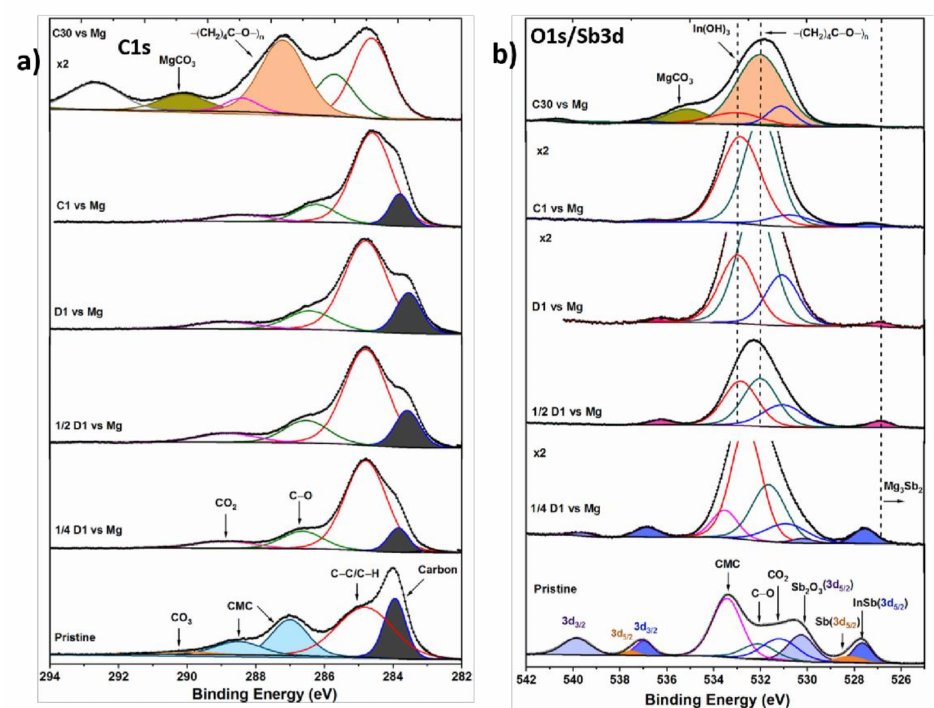
Figure 3. ( a ) C1s and ( b ) O1s/Sb3d core peaks spectra of the InSb electrode cycled in EtMgCl–Et2AlCl/THF electrolyte vs. Mg. 1 D1, 1 D1, D1, C1, and C30 denote the first one-quarter discharge, first half discharge, first discharge, first charge, and 2 4 30th charge, respectively. All spectra were calibrated by considering the adventitious carbon peak (C-C/C-H) at 284.8 eV.